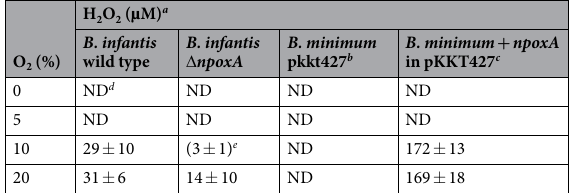
Table 1. H 2 O 2 accumulation of B. infantis and B. minimum under 0% to 20% O 2 conditions. a H 2 O 2 accumulation in the medium (24 h). b Vector pKKT427 was transformed into B. minimum . c The B. infantis npoxA gene was cloned in pKKT427 and transformed into B. minimum . d ND, not detected (less than 3 µ M). e Data in parentheses are close to the reliable detection limit. Data represent the average ± SD of three independent cultures.